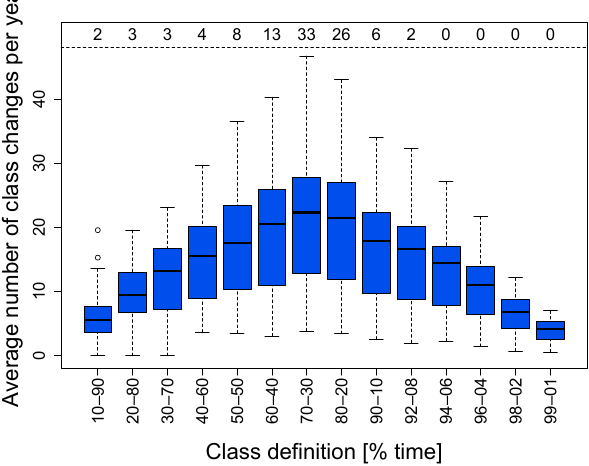
Figure 7. Box plots of the average number of times per year that the water level switched from one class to another for different class definitions. In the top row the number of catchments for which the number of water level class switches was highest at that class def- inition. As an example, 80–20 indicates that streamflow was in the lower stream level class for 80% of the time and in the upper stream level class for 20% of the time, and that for 26 of the 100 catch- ments this class boundary definition resulted in most class switches per